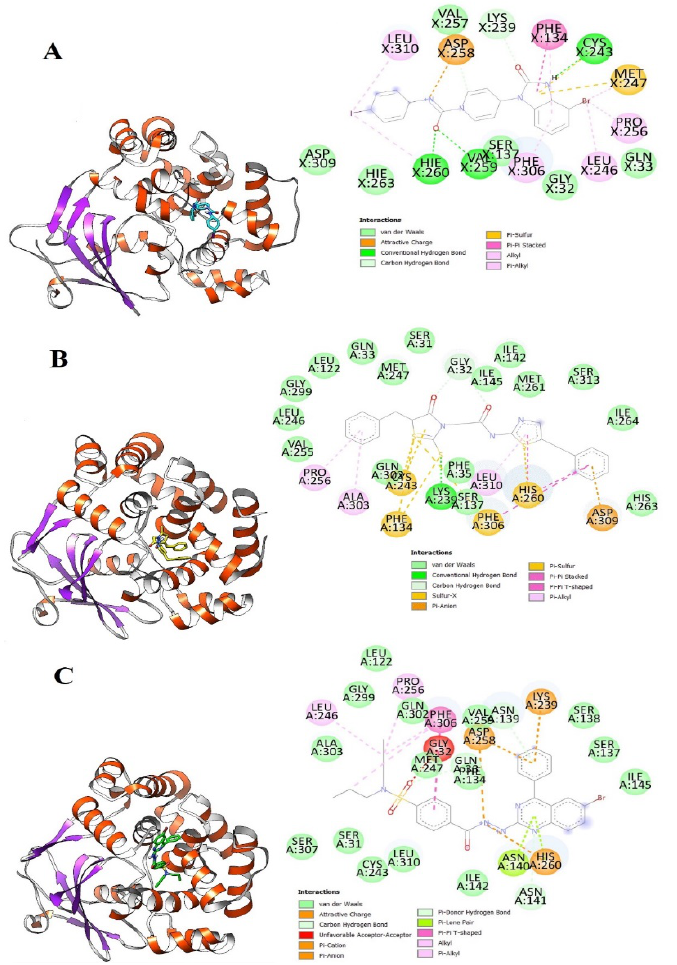
Figure 1. Molecular docking analysis of Control and shortlisted best binders . Both intermolecular docking conformation and interactions are provided. ( A ) 3D conformation of Control (shown in cyan stick), ( B ) Top-1 (shown in yellow stick), and ( C ) Top-2 (shown in green stick) at the active pocket of OGG1 enzyme (shown in secondary structure ribbon), and 2D presentation of enzyme residues interaction with the compounds.